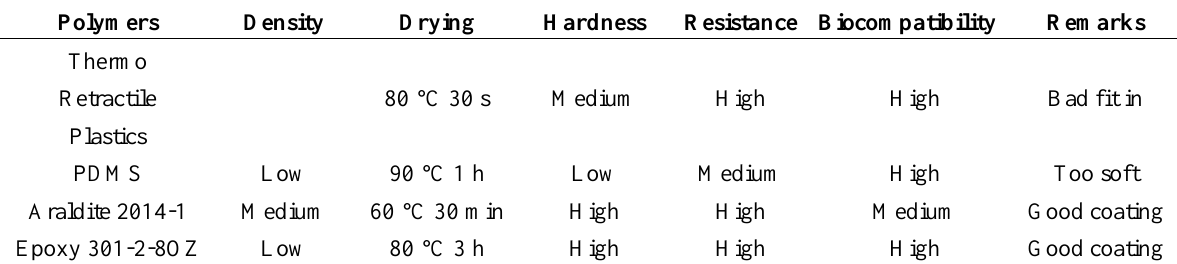
Table 1. Different properties of the insulation material were tested.